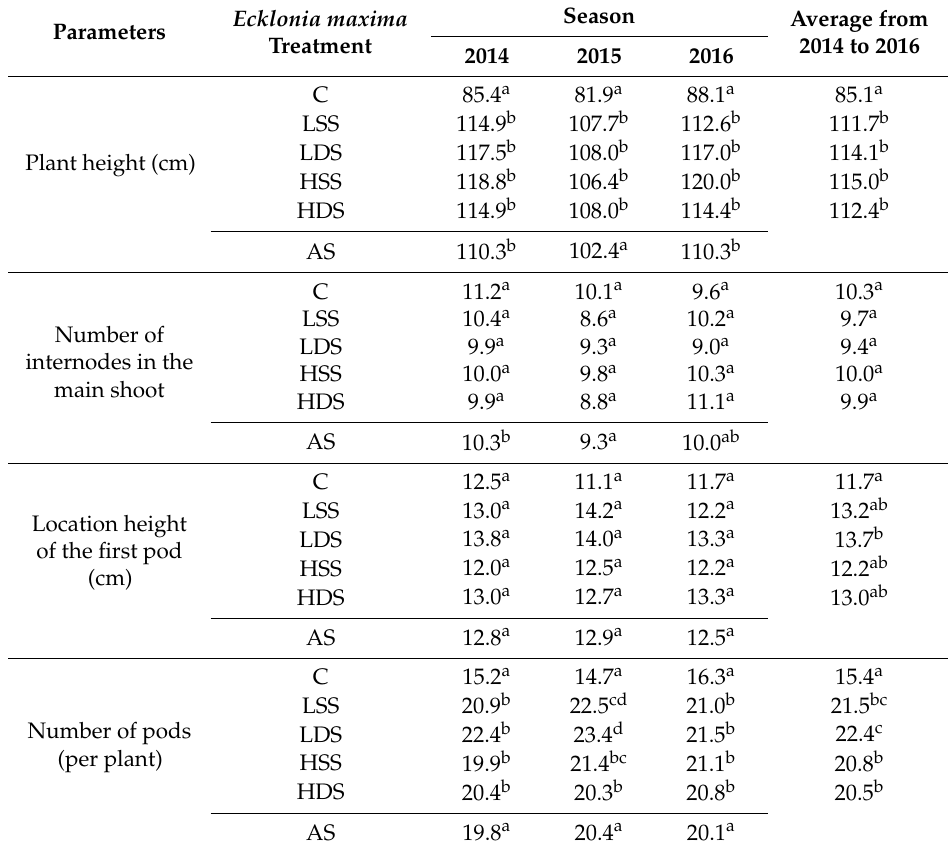
Table 3. Effect of Ecklonia maxima extract (Kelpak) treatment on biometric traits of soybean (average from